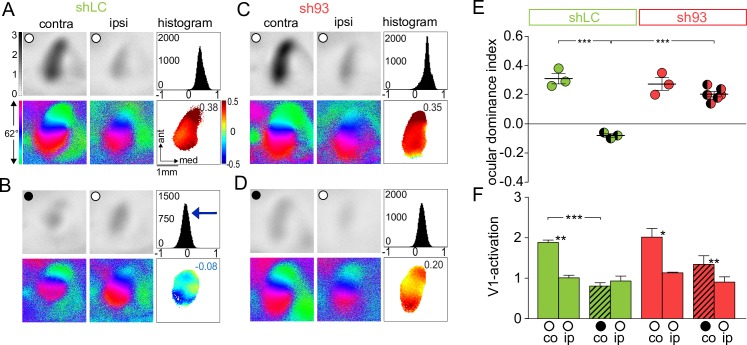
Knock-down of PSD-93 in the visual cortex phenocopied the PSD-93 KO effect: Juvenile ODP was absent in late critical period.(A-D) Optically imaged activity maps in V1 of WT mice with shLC (A, B) and with sh93 (C, D) during late CP (≥P28) before (A, C) and after 4 d of MD (B, D). Data displayed as in Fig 3. (E, F) Summary graph of ODI (E) and V1 activation (F). ○, open eyes; ●, deprived eyes. ODIs (E) and V1 activation (F) before (oo) and after (●o) 4 d MD in WT mice with shLC (green) and with sh93 (red). Data displayed as in Fig 3. *p < 0.05, **p < 0.01, ***p < 0.001. Underlying data for this figure can be found in S1 Data. ant, anterior; co, contralateral; contra, contralateral; CP, critical period; KO, knock-out; ip, ipsilateral; ipsi, ipsilateral; MD, monocular deprivation; ODI, ocular dominance index; ODP, ocular dominance plasticity; P, postnatal day; PSD, postsynaptic density; shLC, short hairpin RNA against luciferase; sh93, short hairpin RNA against PSD-93; V1, primary visual cortex; WT, wild-type.